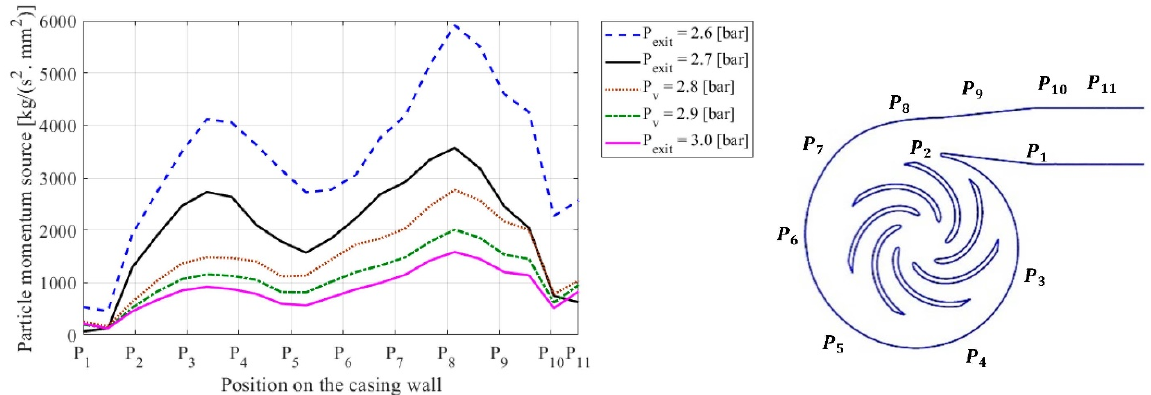
Figure 17. Variation of concentration of particles along the casing wall with different values of exit pressure heads.